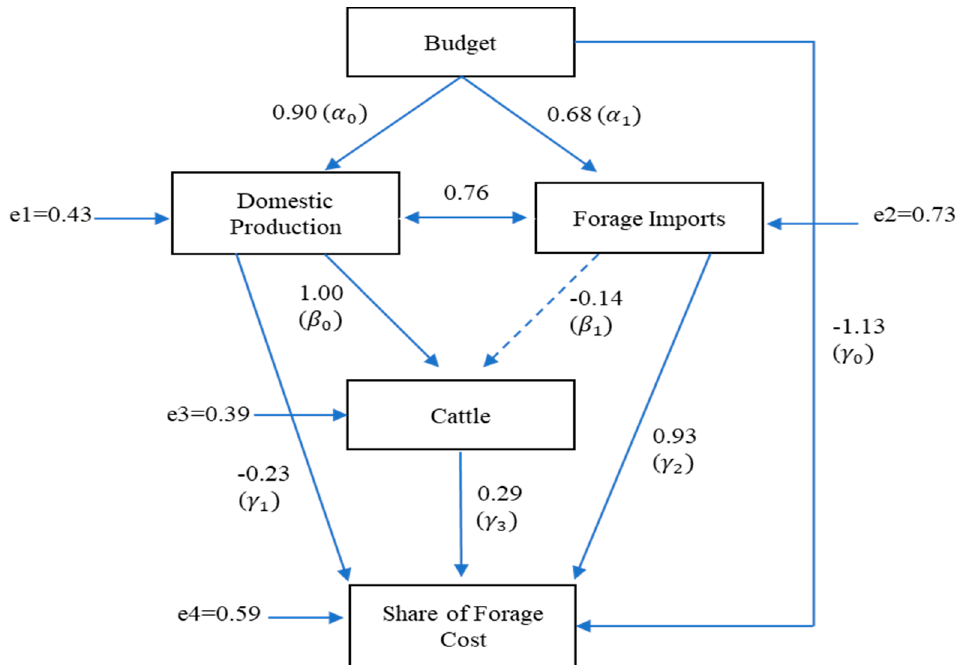
Figure 1. Path-analysis diagram for how feed cost is affected by government spending on domestic forage production in Korea, from 1998 to 2016. All the lines in the diagram represent a specific linear model. Solid lines indicate good evidence for an effect (95% or higher significance), and dotted lines indicate no clear relationship.